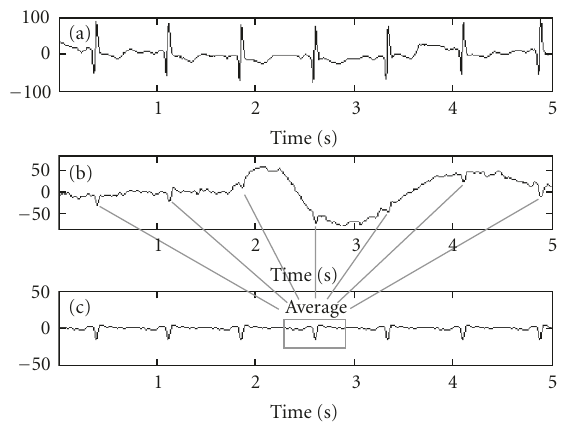
Figure 8: (a) ECG, (b) EEG corrupted by ECG artifact, (c) artificial reference used for